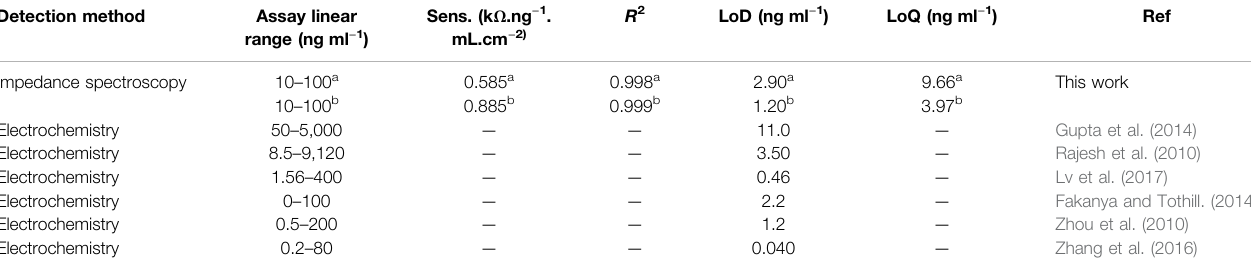
TABLE 1 | Analytical parameters for the electrochemical immunosensor for CRP antigen detection compared with reported methods. Detection method